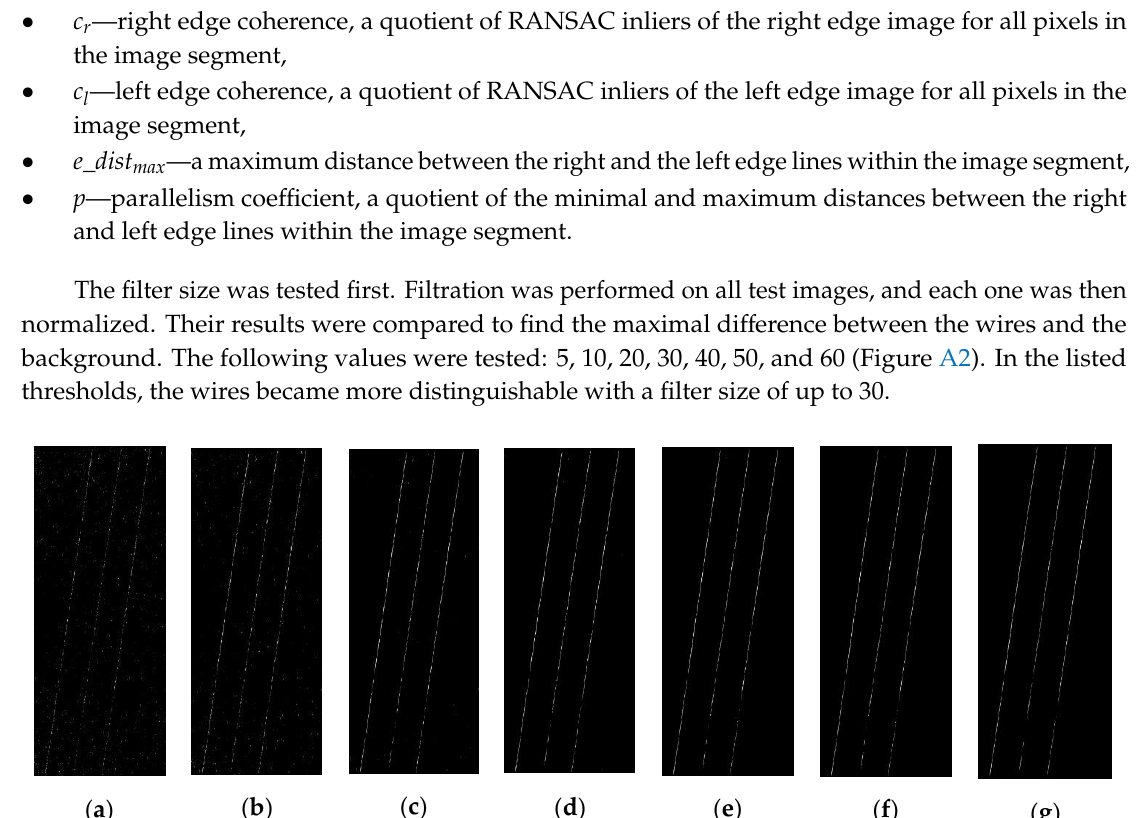
Figure A1. Sample images used for threshold sensitivity analysis: ( a ) ID 217, ( b ) ID 36.